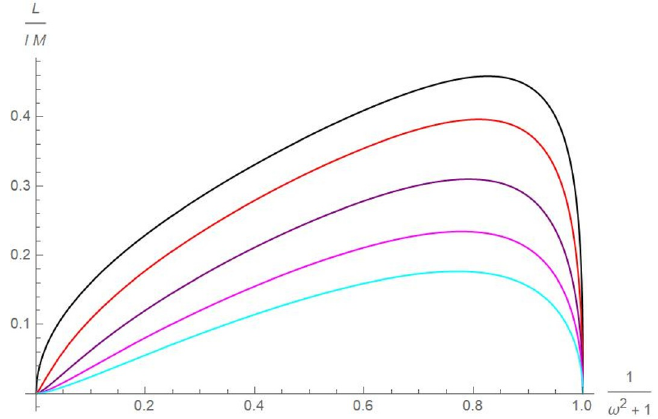
Figure 6 . In black L/M for the straight open string that rigidly rotates, as in [2]. The other curves are for increasing masses added at the two ends of the string, ranging from 0.25 in red to 1 in